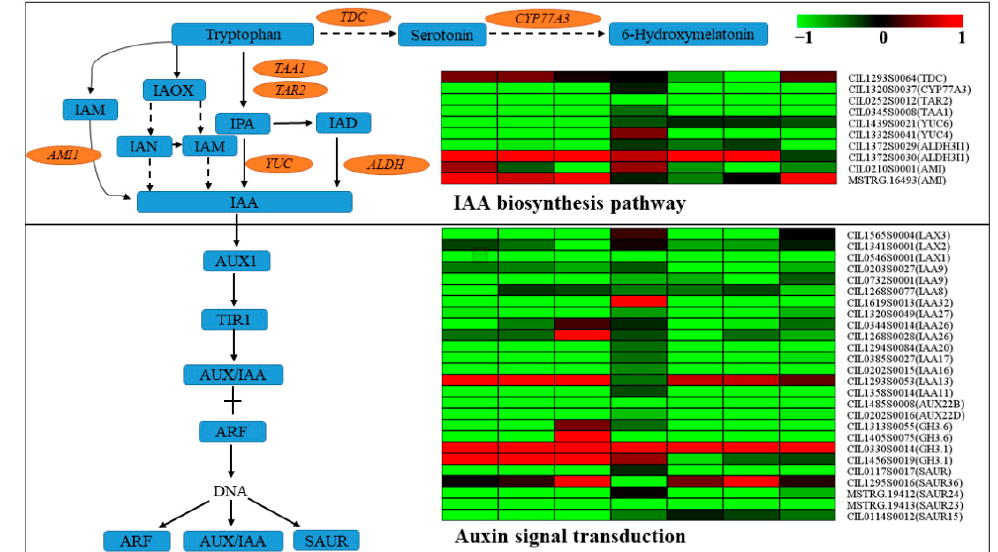
Figure 8. DEGs involved in AUX biosynthesis pathways and signaling transduction pathways. Responsive progression of genes expressions under different samples infection with PMV compared to the control (CK), indicated in 7-box strings (including Y1-vs.-CK, Y2-vs.-CK, Y3-vs.-CK, G1-vs.-CK, G2-vs.-CK, G3-vs.-CK, ML-vs.-CK). Heat maps were drawn using the Log2 ratio (transformed FPKM value of PMV infection/those of CK). Detailed genes and expressions data were provided in Tables S15 and S16, available as Supplementary Data online. TAA1, tryptophan aminotransferase of Arabidopsis 1; TAR2, tryptophan aminotransferase related 2; IAOx, indole-3-acetaldoxime; IAM, indole-3-acetamide; IAN, indole-3-acetonitrile; AMI, indole-3-acetamide hydrolase; IPA, indole-3- pyruvic acid; IAA, indole-3-acetic acid; TDC, tryptophan decarboxylase; IAD, indole-3-acetaldehyde; ALDH, aldehyde dehydrogenase; YUC, indole-3-pyruvate monooxygenase YUCCA; ARF, auxin response factors; LAX, auxin transporter-like protein; IAA, auxin-responsive protein IAA; GH3, indole-3-acetic acid-amido synthetase GH3; SAUR, auxin-responsive protein SAUR; TIR, transport inhibitor response. The heat maps indicated the upregulation (red) and downregulation (green) of genes in PMV-infected samples compared to CK.